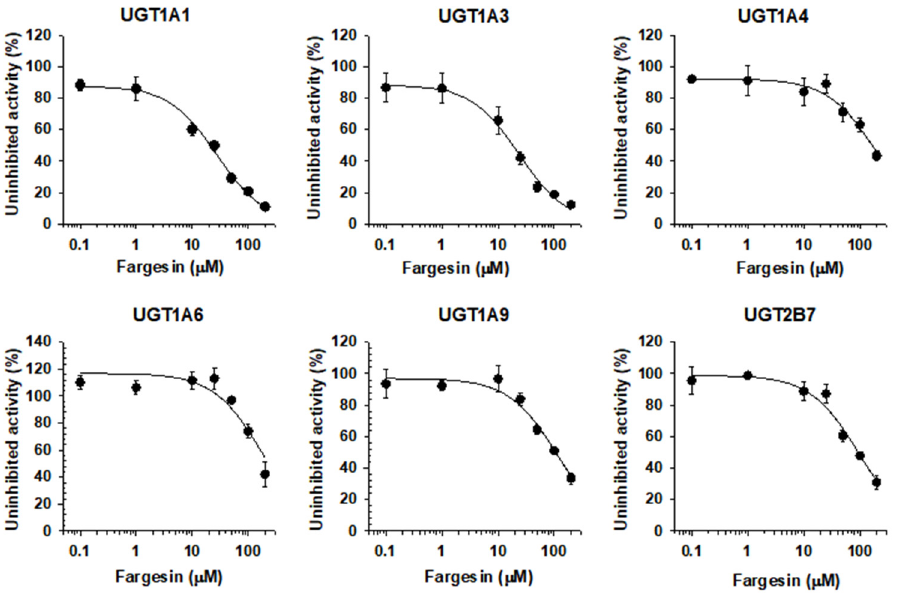
Figure 3. Inhibitory effects of fargesin (0.1–200 µ M) on UGT1A1-, UGT1A3-, UGT1A4-, UGT1A6-, UGT1A9-, and UGT2B7- mediated glucuronidation of 0.5 μ M SN-38, 2 μ M chenodeoxycholic acid, 0.5 μ M trifluoperazine, 1 μ M N -acetylserotonin, 0.2 μ M mycophenolic acid, and 1 μ M naloxone, a probe substrate for UGT1A1, UGT1A3, UGT1A4, UGT1A6, UGT1A9, and UGT2B7, respectively, in human liver microsomes. The data are expressed as means ± standard deviations ( n = 3). Table 1. Inhibitory potentials of eudesmin, fargesin, epimagnolin A, magnolin, and yangambin on six major UGT enzyme activities in ultrapooled human liver microsomes.